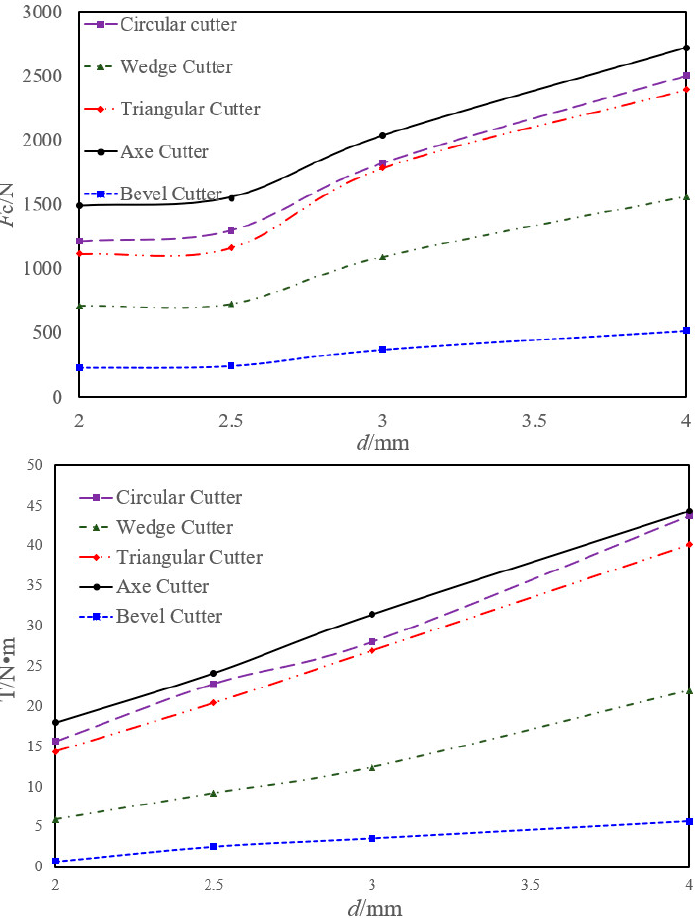
Figure 7. Numerical simulation results of F c and T . The top subfigure is the curve of F c with d ; the bottom subfigure is the curve of T with d .